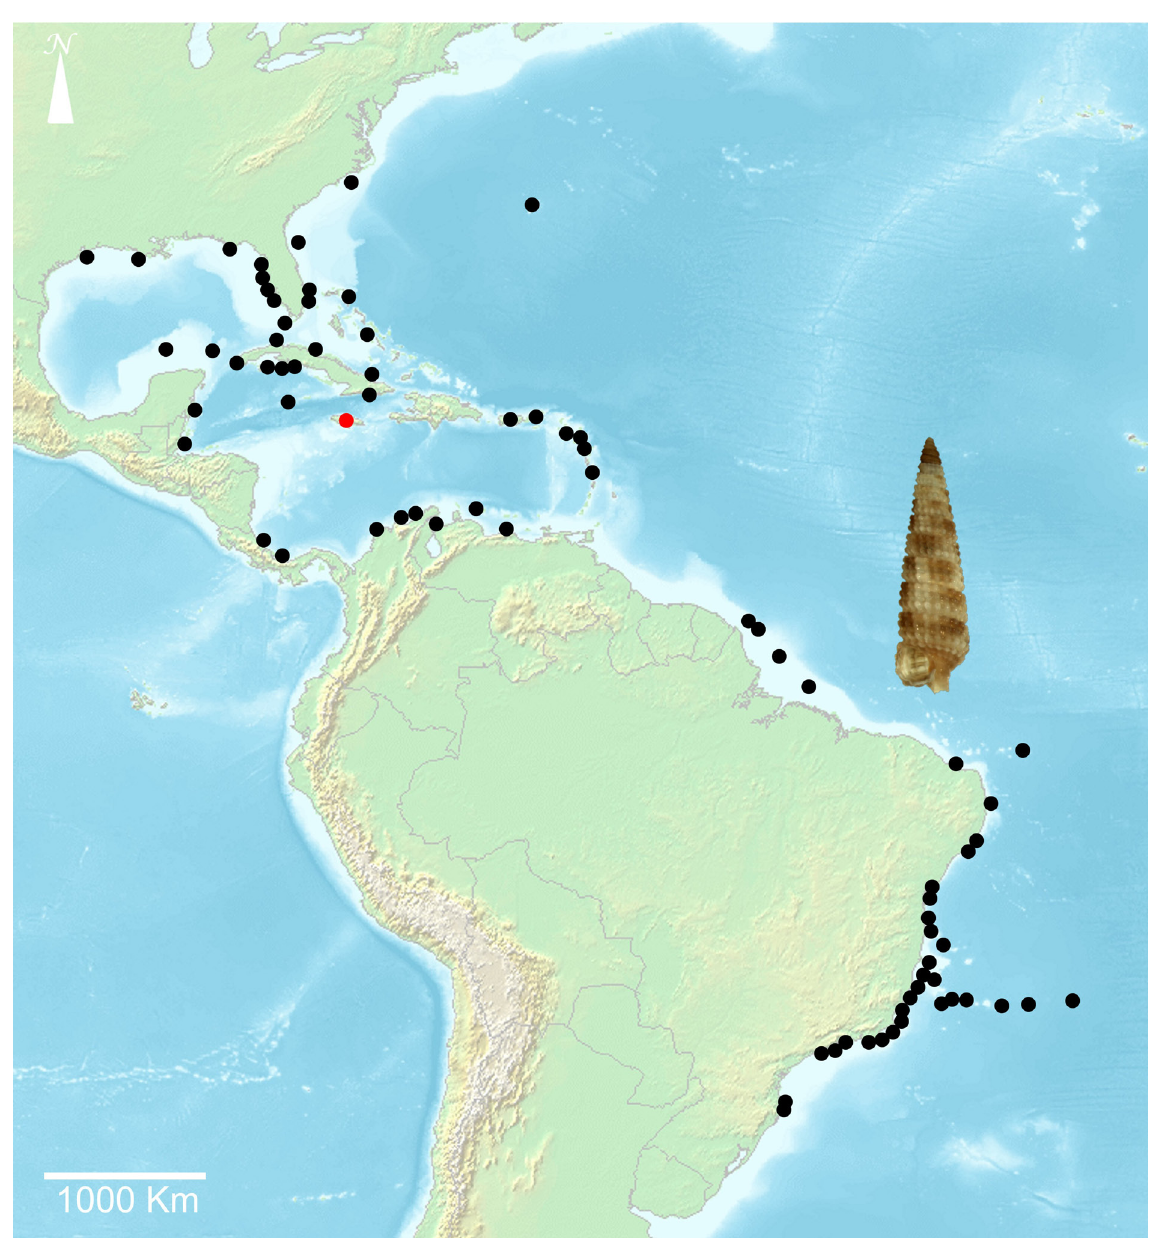
Fig. 61. Distribution map of Nototriphora decorata (C.B. Adams, 1850); red circle = type